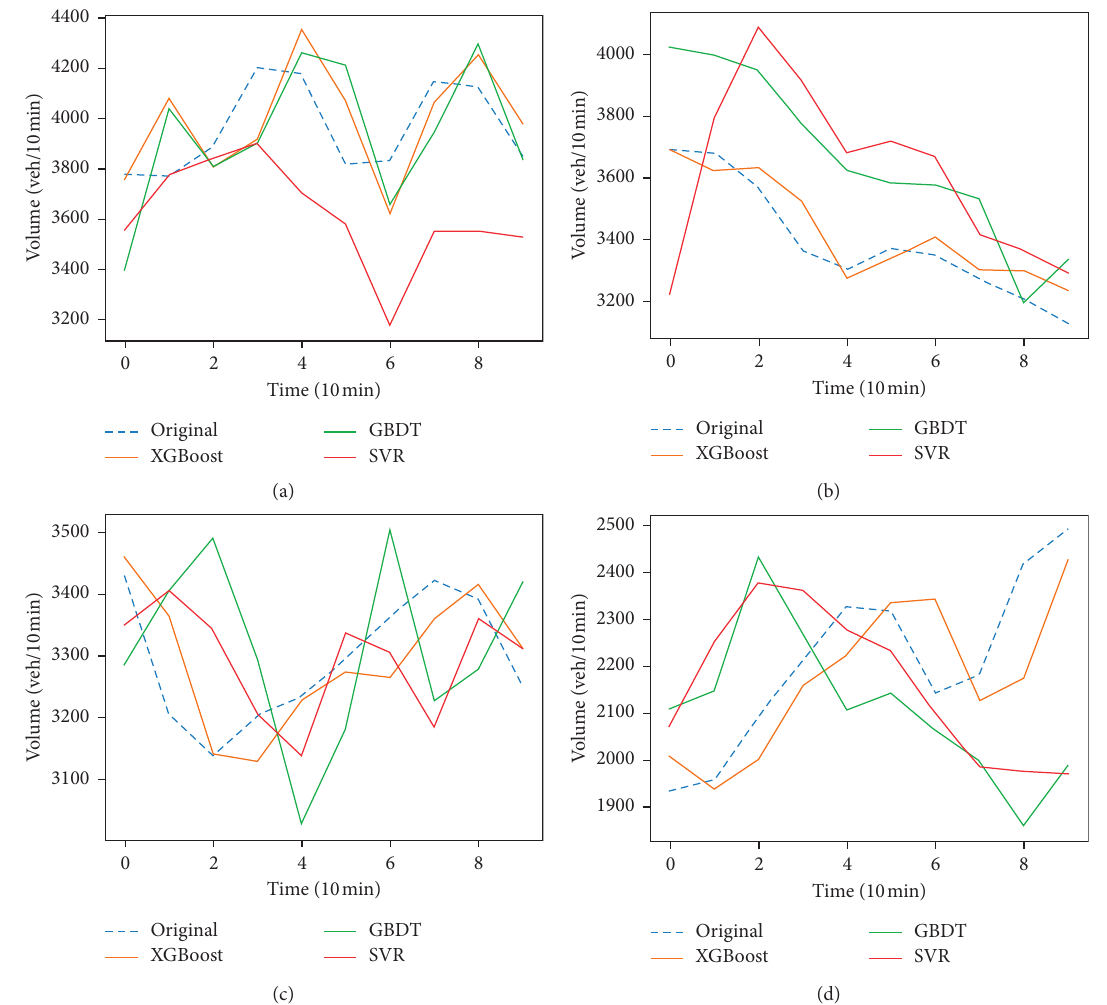
Figure 1: The comparison with frequently used models at four challenging